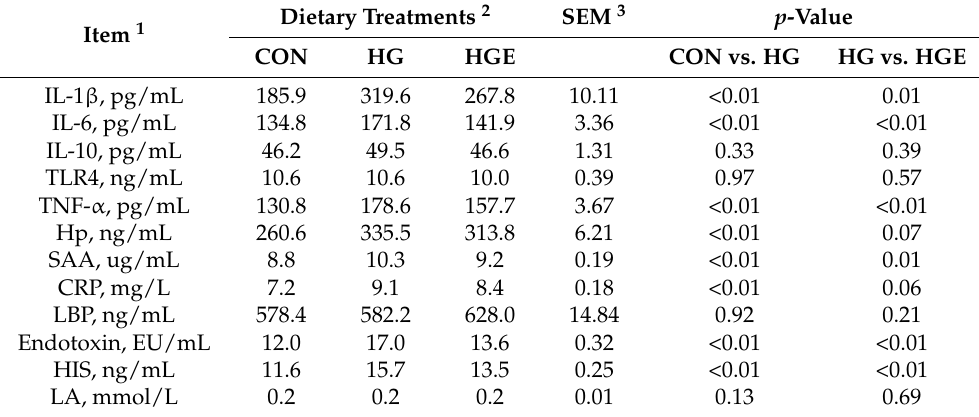
Table 7. Effects of vitamin E on plasma immune indices induced by high concentration in subacute ruminal acidosis